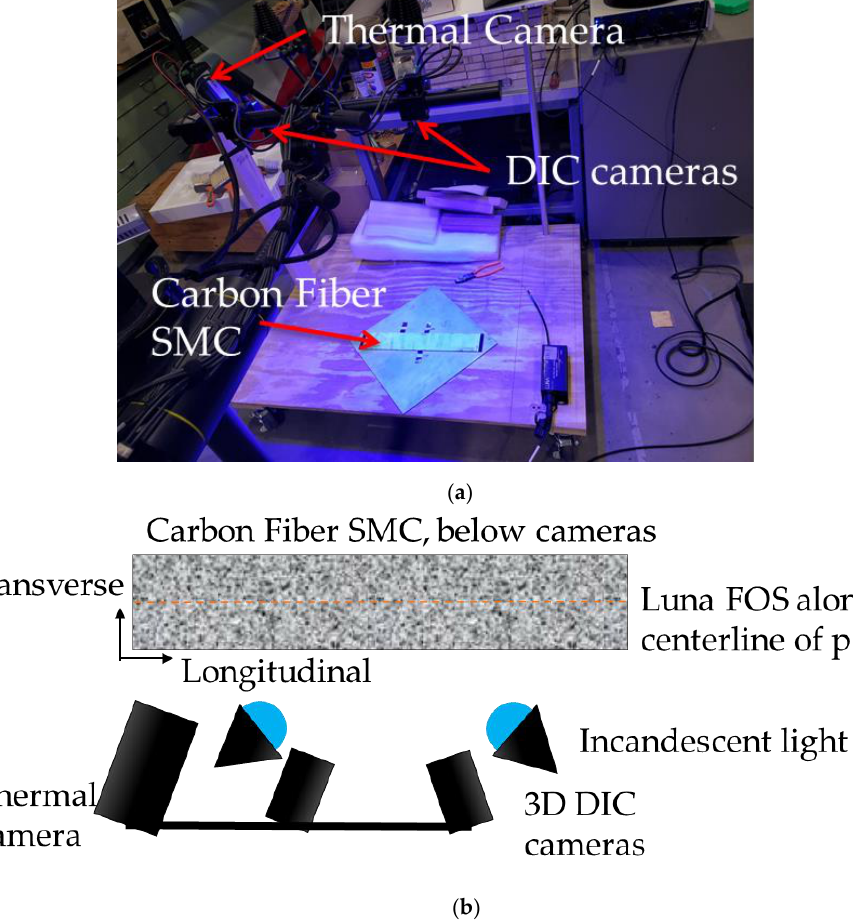
Figure 3. Image ( a , b ) schematic of the experimental setup for thermal digital image correlation (TDIC)